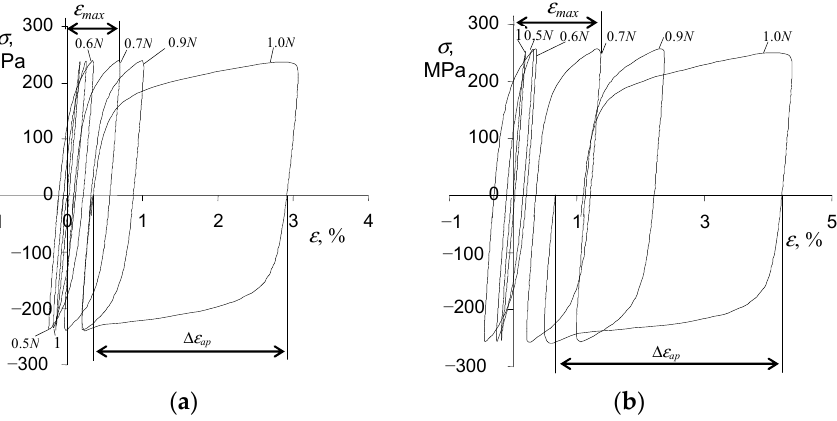
Figure 5. Hysteresis loops recorded in fatigue tests ( τ = 0, T = 600 ◦ C): ( a ) σ a = 225 MPa, ( b ) σ a = 249 MPa.